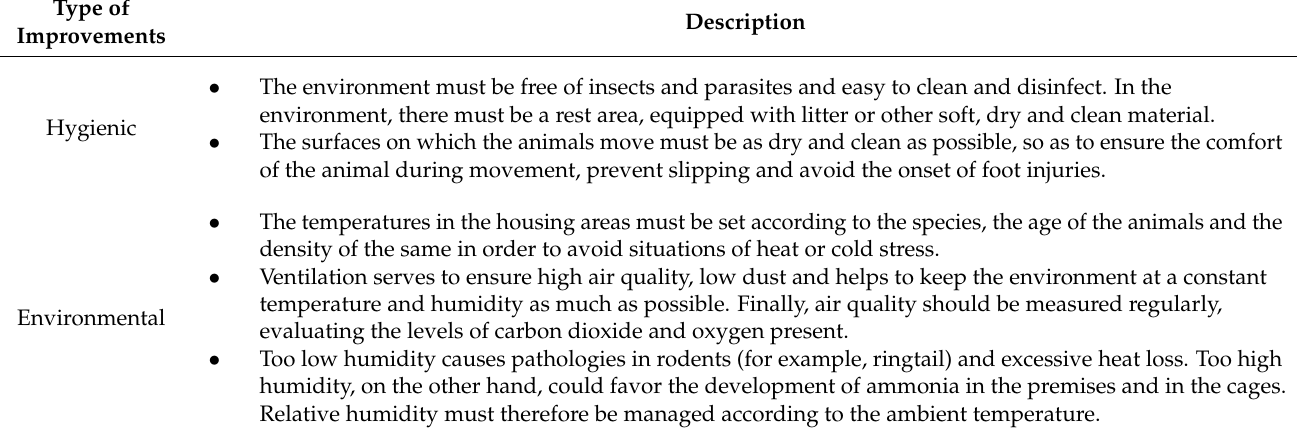
Table 1. Animal shelters and environmental